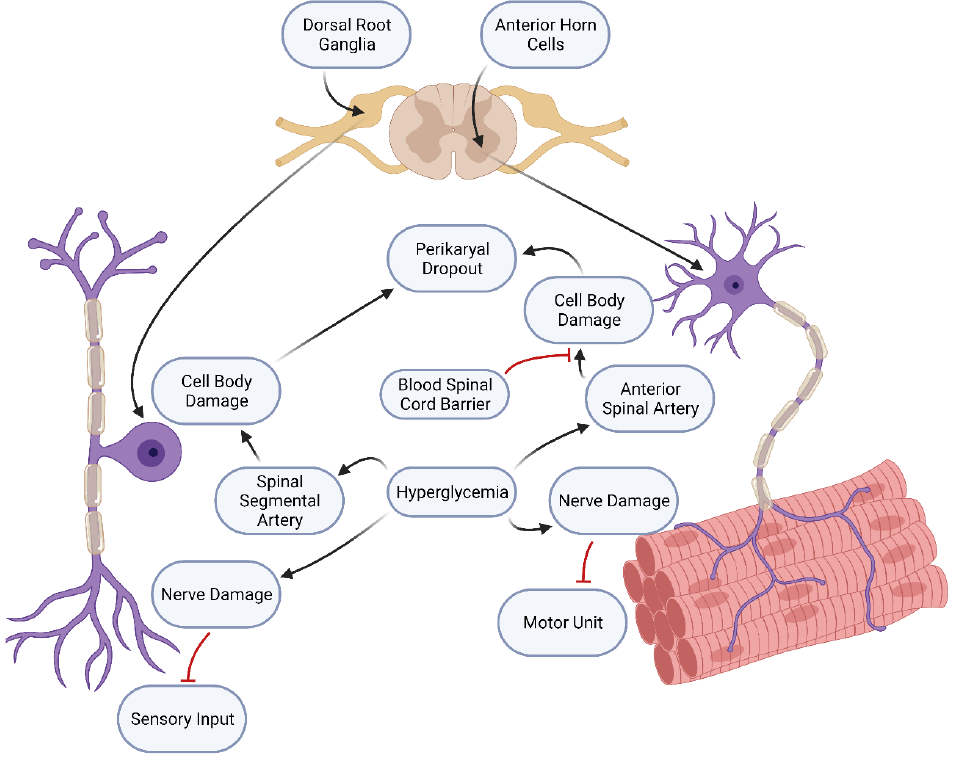
Figure 2. Diabetic damage to sensory vs. motor nerves: hyperglycemia causes different types of damage, depending on the location of nerve cell bodies. Sensory nerve cell bodies are located in the dorsal root ganglia, which are supplied by spinal segmental arteries. Hyperglycemia in this blood supply causes axonal damage and cell body damage, leading to a loss of sensory input and perikaryal dropout. Motor nerve cell bodies are located in the anterior horns of the spinal cord. The blood – spinal cord barrier, similar to the blood – brain barrier, protects these cell bodies from the damaging effects of hyperglycemia. However, the axons of motor nerves and their motor units can still be damaged, leading to the loss of motor function.